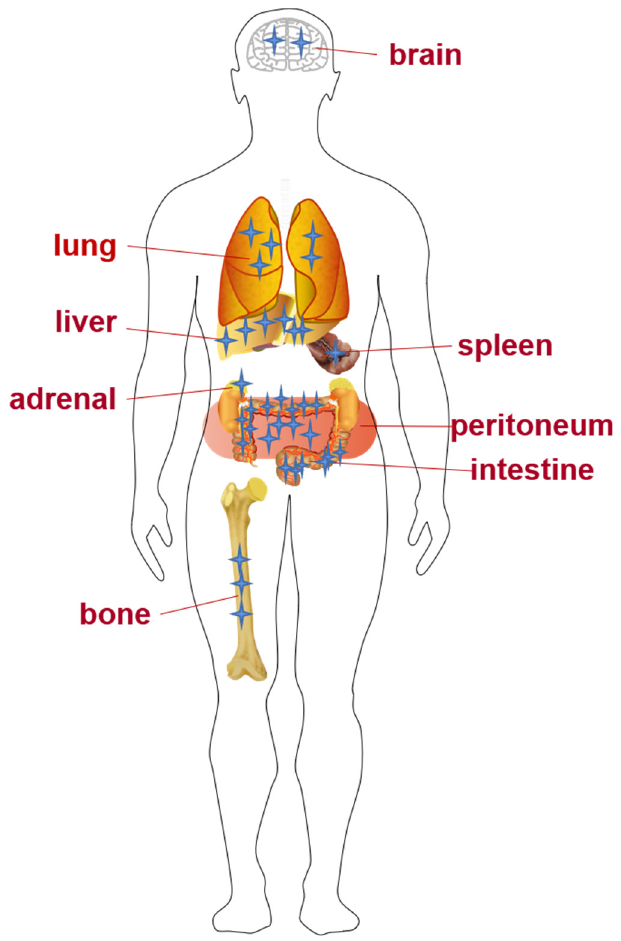
Figure 1. Invasion and metastasis of CRC. The number of asterisks in organs represents the amount of CRC tumor cells localized.